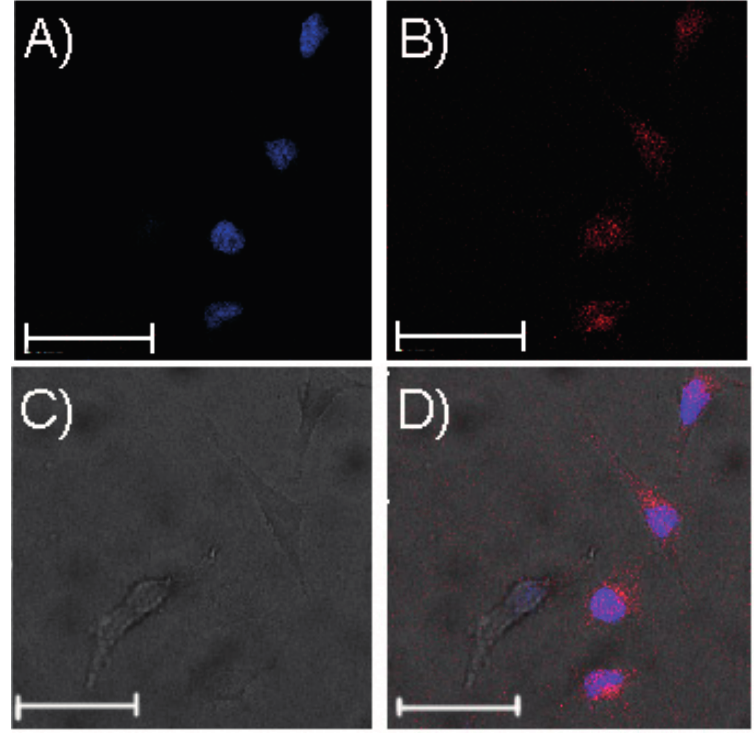
Figure 4. Fluorescence images of primary cultured U251 cells labelled with dendrime modified QDs. The U251 cells were stained by DAPI (Blue, A ); Dendrimer modified CdTe/CdS QDs (Red, B ); bright field ( C ) and merge images ( D ); Original magnification of ( A – D ) is